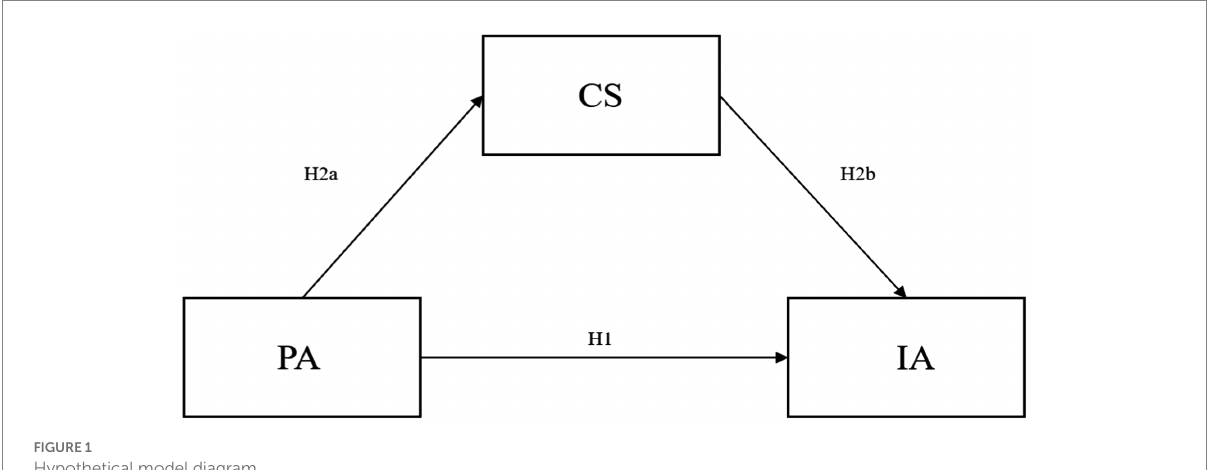
FIGURE 1 Hypothetical model